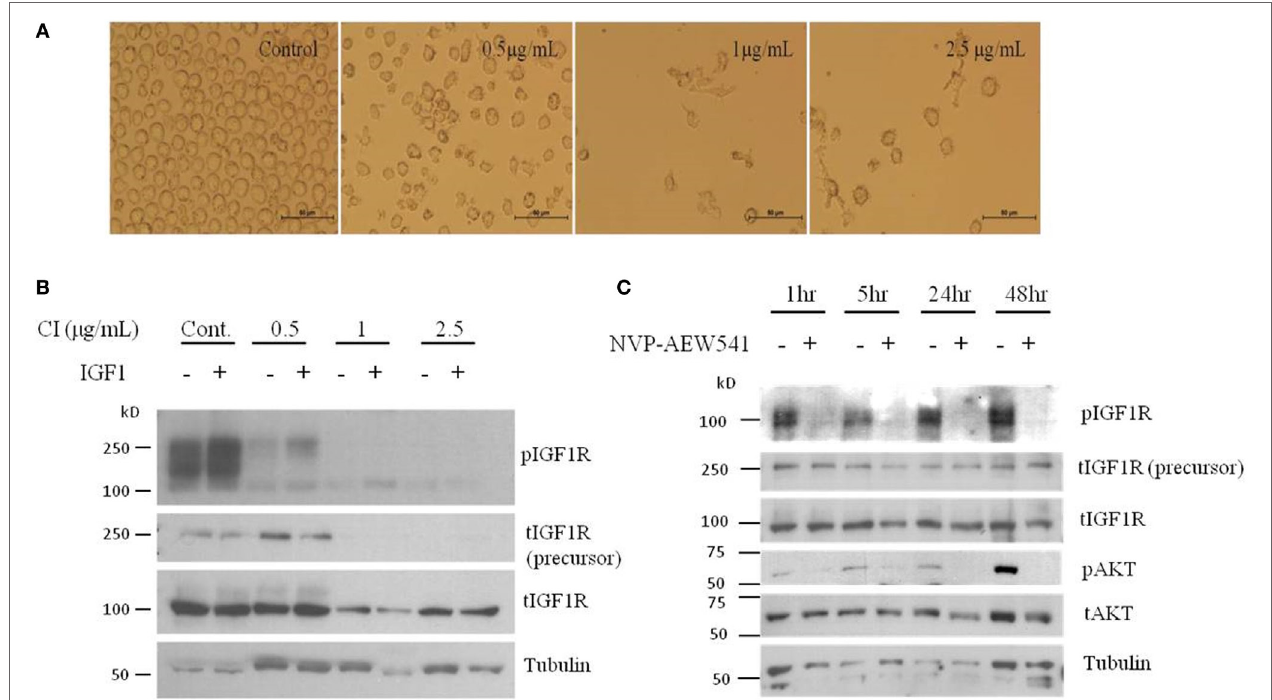
FiGUre 1 | Dendritic cell (DC) differentiation of HL-60 cells show reduced total and phosphorylated IGFIR protein levels. (A) Human leukemic HL-60 cells were differentiated to DCs by treatment with 0.5, 1, and 2.5 μ g/ml of calcium ionophore (CI) for 72 h. (B) Human leukemic HL-60 cells were treated with 0.5, 1, and 2.5 g/ ml of CI for 72 h and 10 min before harvest, cells were treated with insulin-like growth factor (IGF)1. Whole-cell lysates were resolved on SDS-PAGE and immunoblotted with the specified antibodies. Level of tubulin was used as a loading control. (c) Human leukemic HL-60 cells were treated with 2 μ M of NVP- AEW541 for 1, 5, 24, and 48 h. Whole-cell lysates were resolved on SDS-PAGE and immunoblotted with the specified antibodies. Level of tubulin was used as a loading